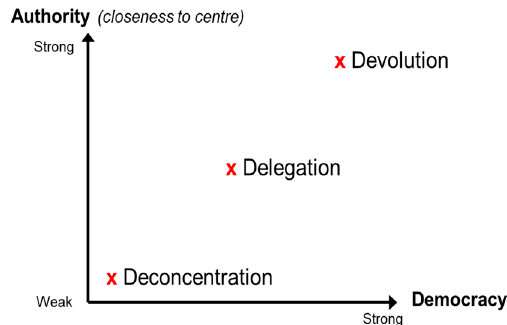
Figure 1. Continuum of decentralized relations and trade-offs between authority and democracy.